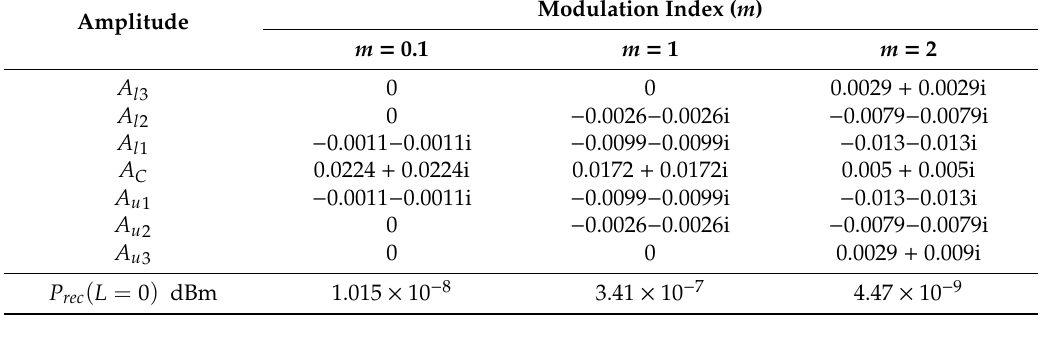
Table 1. Calculation of P rec ( L = 0 ) for ODSB modulation ( θ = 180 ◦ ).